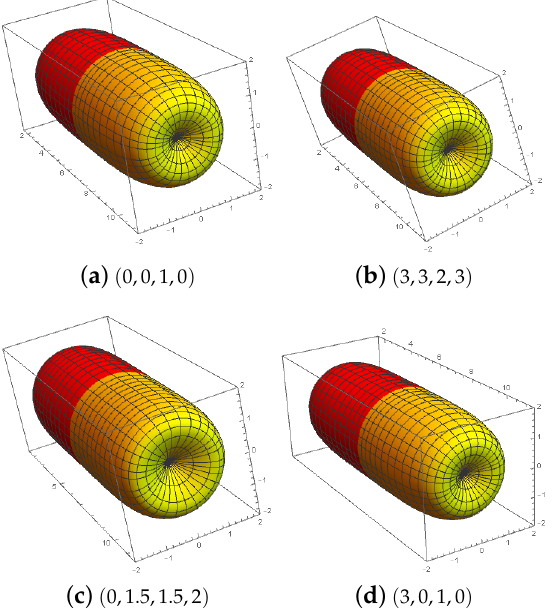
Figure 7. Symmetric Bézier-like rotation surfaces of the capsule torus with different values of shape controls χ , ϑ , χ 1 and ϑ